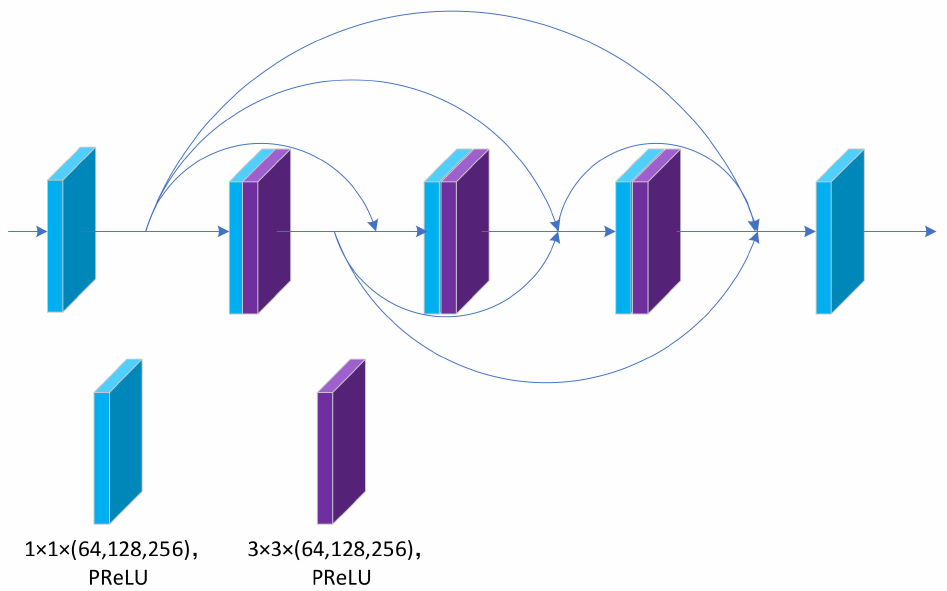
Figure 8. Fully dense fusion (FDF) block structure diagram; numbers in parentheses indicate the number of channels output by FDF at the PAN, middle, and MS